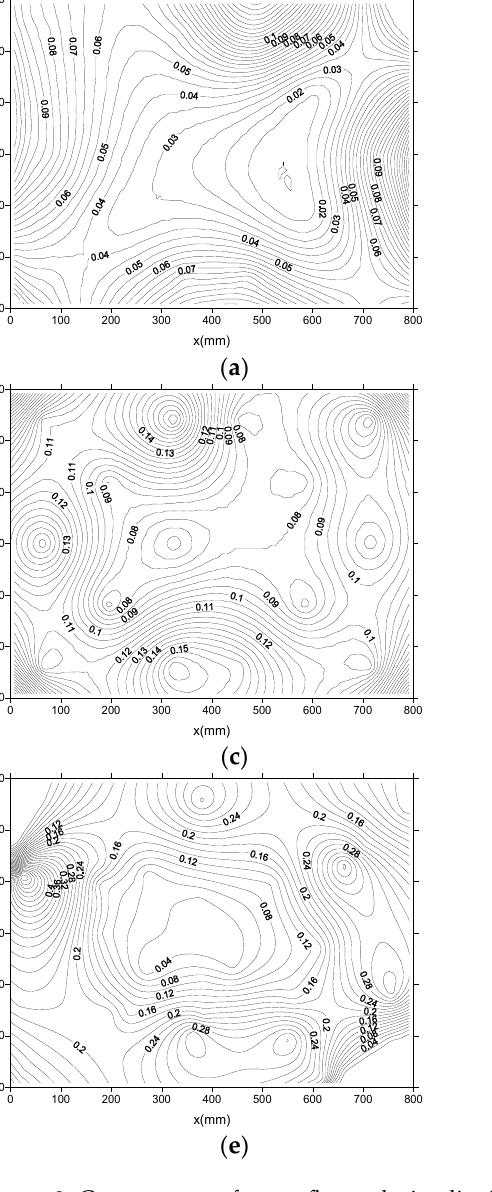
Figure 3. Contour map of water flow velocity distribution in the main reaction zone at each aeration amounts. ( a ) 0.04 m 3 /h (Unit: m/s), ( b ) 0.06 m 3 /h (Unit: m/s), ( c ) 0.10 m 3 /h (Unit: m/s), ( d ) 0.15 m 3 /h amounts. ( a ) 0.04 m 3 / h (Unit: m / s), ( b ) 0.06 m 3 / h (Unit: m / s), ( c ) 0.10 m 3 / h (Unit: m / s), ( d ) 0.15 m 3 / h (Unit: m/s), ( e ) 0.20 m 3 /h (Unit: m/s), ( f ) 0.3 m 3 /h (Unit: m/s). (Unit: m / s), ( e ) 0.20 m 3 / h (Unit: m / s), ( f ) 0.3 m 3 / h (Unit: m /